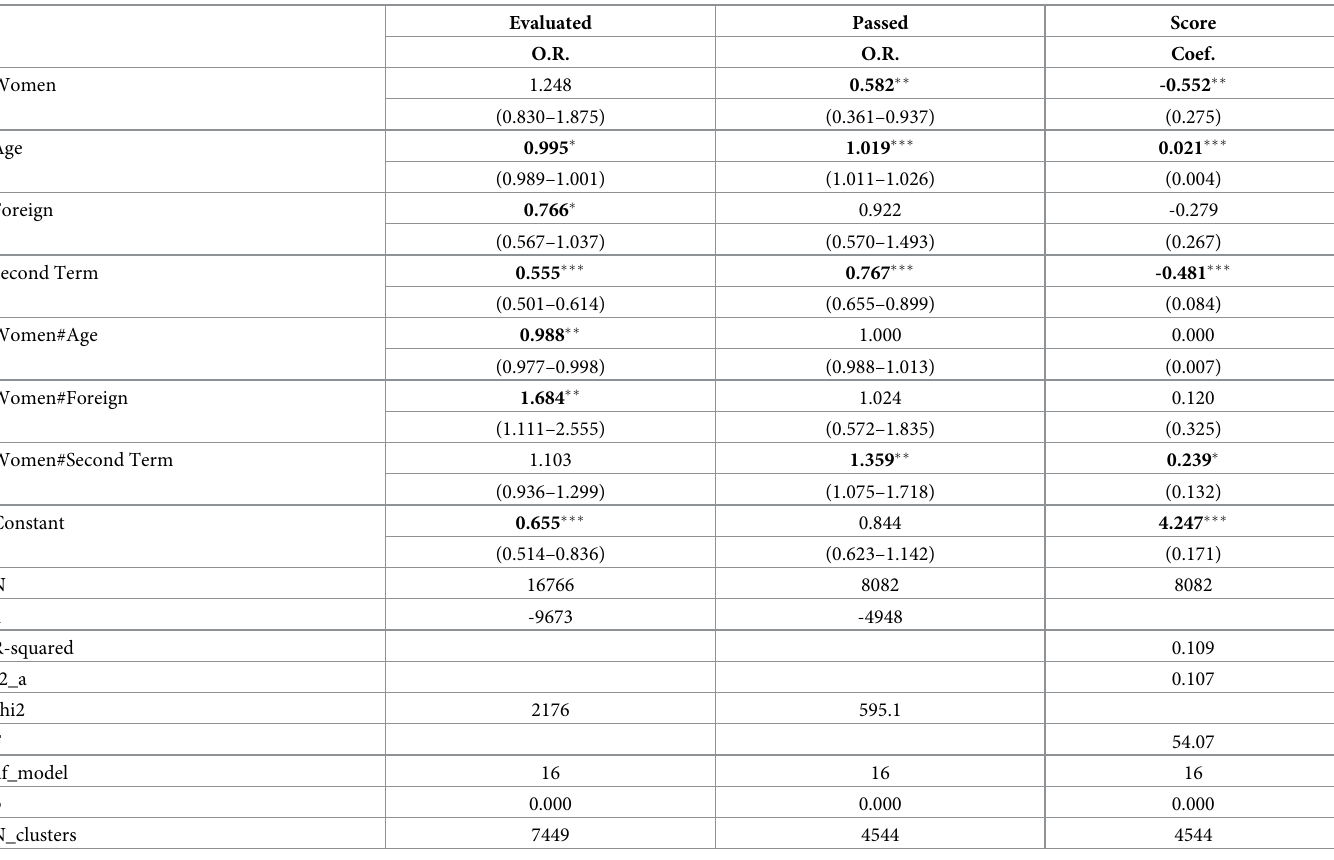
Table 7. Selected estimation results in the whole model with interactions: Sex